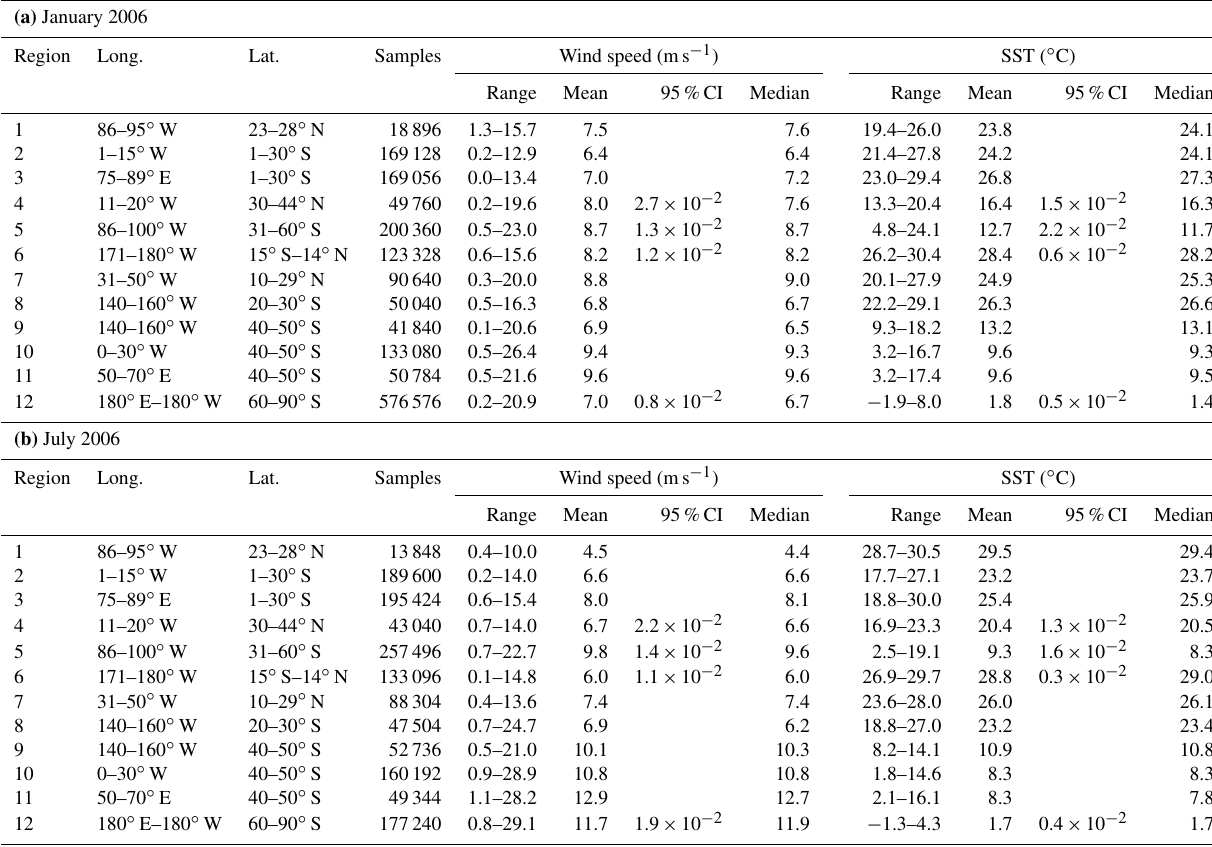
Table 1. Coordinates (longitude and latitude), number of data points are given together with range, mean and median values for wind speed and SST of all selected regions for (a) January 2006 and (b) July 2006. CIs at 95% level are given for regions 4, 5, 6, and 12, whose seasonal variations are plotted in Fig.